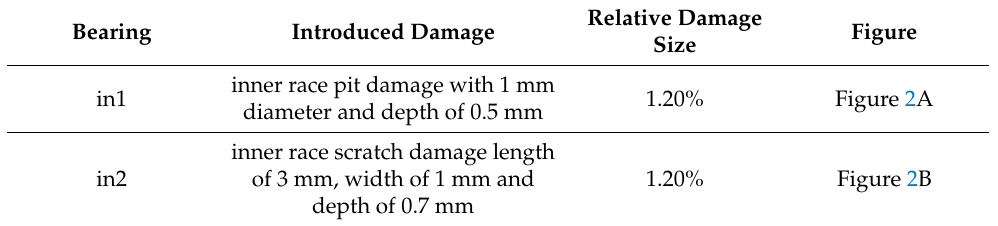
Table 1. List of damaged bearings, with introduced damage and relative damage sizes [26].